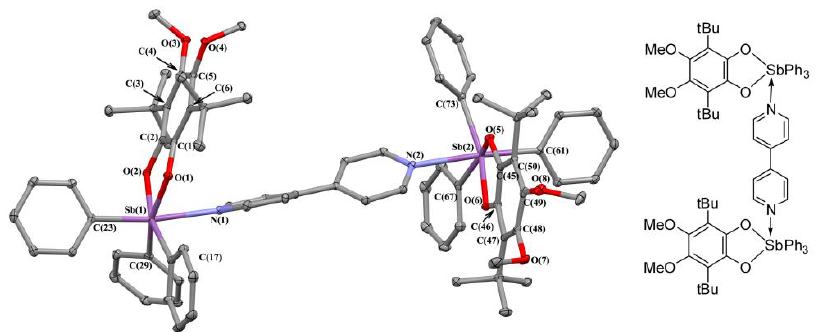
Figure 1. The X-ray structure of 1 (thermal ellipsoids here and below of 50% probability). The hy- drogen atoms are omitted. The selected bond lengths ( Ǻ ) and angles (°): Sb(1)-O(1) 2.0194(12), Figure 5. The X-ray structure of 8 . The hydrogen atoms are omitted. The selected bond lengths ( Figure 5. The X-ray structure of 8 . The hydrogen atoms are omitted. The selected bond lengths (Ǻ) Sb(1)-O(2) 2.0326(12), Sb(1)-N(1) 2.773(5), Sb(1)-C(15) 2.1246(19), Sb(1)-C(21) 2.1433(18), Sb(1)-C(27) and angles (°): Sb(1)-O(1) 2.0316(17), Sb(1)-O(2) 2.0291(17), Sb(2)-O(5) 2.0429(17), Sb(2)-O(6) 2.1434(18), O(1)-C(1) 1.353(2), O(2)-C(2) 1.361(2); O(1)-Sb(1)-O(2) 79.69(5), O(1)-Sb(1)-C(21) Sb(1)-N(1) 2.494(2), Sb(2)-N(2) 2.520(2), Sb(1)-C(17) 2.151(2), Sb(1)-C(23) 2.129(2), Sb(1)-C(29) 2.146(2), 2.0415(16), Sb(1)-N(1) 2.494(2), Sb(2)-N(2) 2.520(2), Sb(1)-C(17) 2.151(2), Sb(1)-C(23) 2.129(2), 155.31(6), O(2)-Sb(1)-C(27) 160.75(6), N(1)-Sb(1)-C(15) 167.87(6). Sb(2)-C(61) 2.132(2), Sb(2)-C(67) 2.154(3), Sb(2)-C(73) 2.141(2), O(1)-C(1) 1.368(3), O(2)-C(2) 1.364(3), Sb(1)-C(29) 2.146(2), Sb(2)-C(61) 2.132(2), Sb(2)-C(67) 2.154(3), Sb(2)-C(73) 2.141(2), O(1)-C(1) O(5)-C(45) 1.357(3), O(6)-C(46) 1.363(3), O(1)-Sb(1)-O(2) 78.78(7), O(1)-Sb(1)-C(29) 159.20(8), O(2)- 1.368(3), O(2)-C(2) 1.364(3), O(5)-C(45) 1.357(3), O(6)-C(46) 1.363(3), O(1)-Sb(1)-O(2) 78.78(7), O(1)-Sb(1)-C(29) 159.20(8), O(2)-Sb(1)-C(17) 163.51(8), N(1)-Sb(1)-C(23) 171.36(8), O(5)-Sb(2)-O(6) 78.19(7), O(5)-Sb(2)-C(67) 159.63(8), O(6)-Sb(2)-C(73) 156.80(8), N(2)-Sb(2)-C(61) 175.53(8).